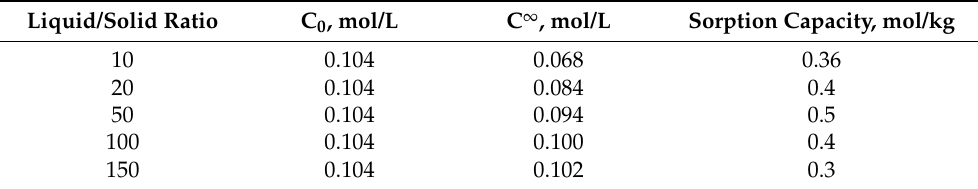
Table 9. Influence of the phase ratio on the sorption extraction of cyclohexanone. Liquid/Solid